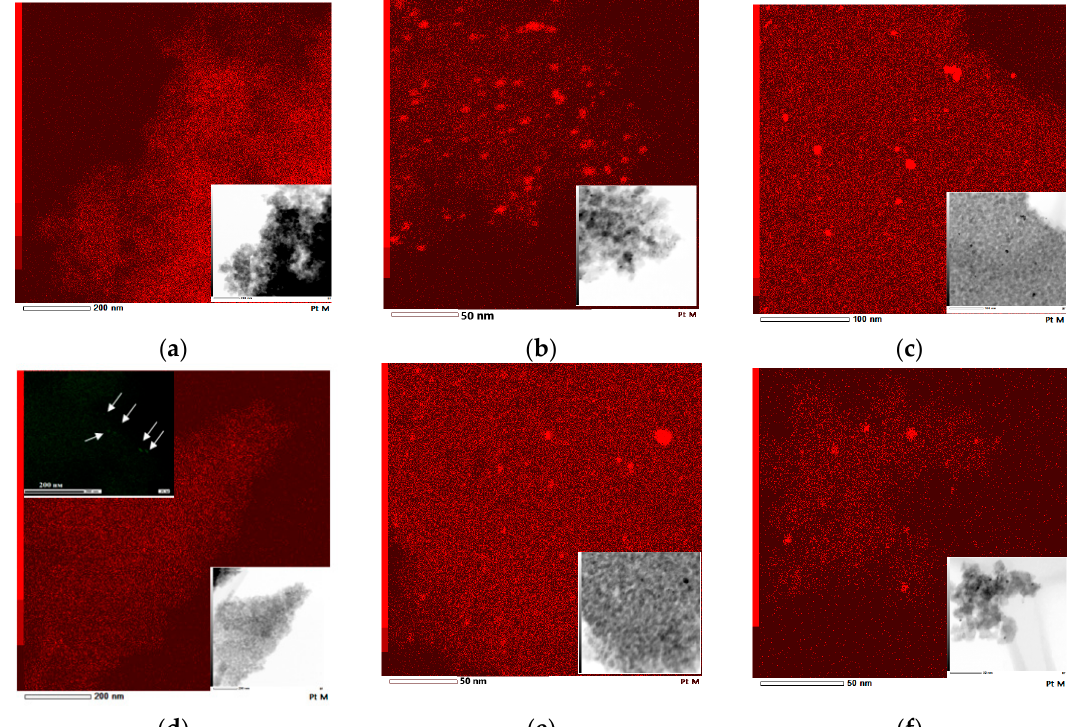
Figure 8. EDS mapping for Pt element and corresponding TEM images (insert): ( a ) 1% Pt-TiO 2M2 ; ( b ) 1% Pt-TiO 2M1 ; ( c ) 1% Pt-TiO 2M1UV ; ( d ) 1% Pt,N-TiO 2M2 ; ( e ) 1% Pt,N-TiO 2M1 ; ( f ) 1% Pt,N-TiO 2M1UV . An